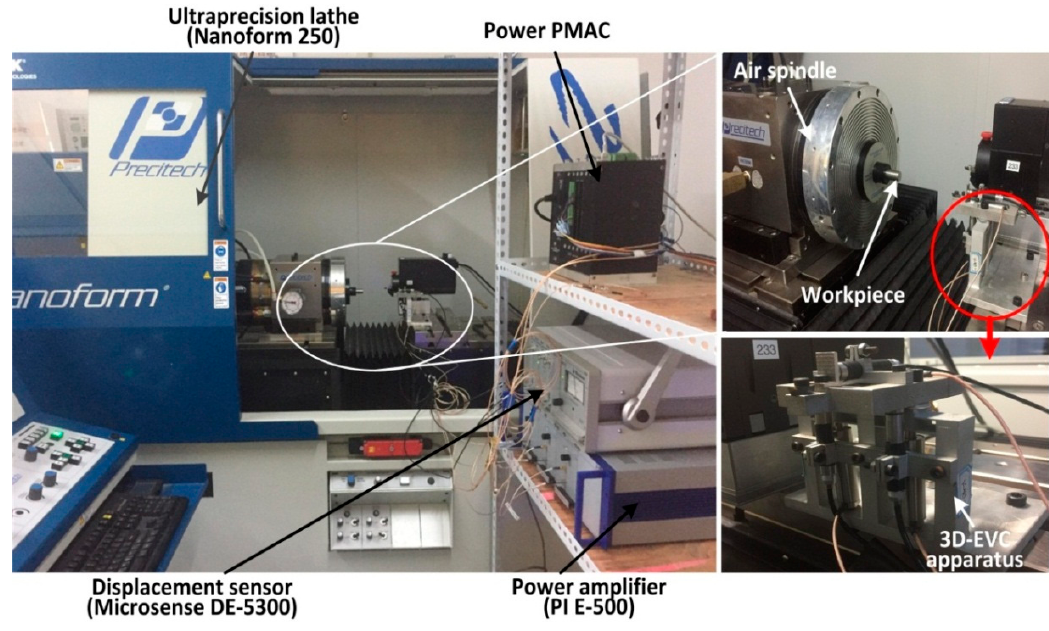
Figure 5. Machine setup of cutting experiments.